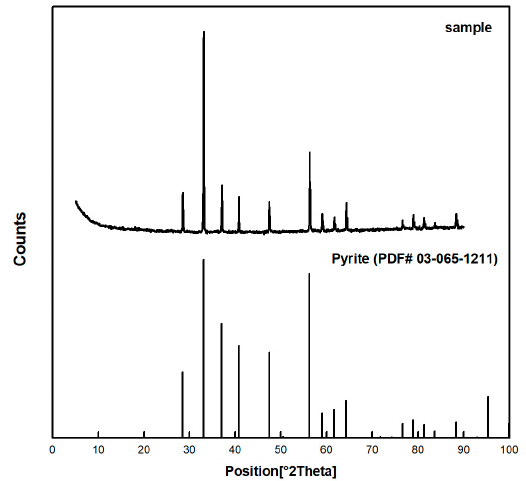
Figure 1. XRD diffraction patterns of pyrite samples.